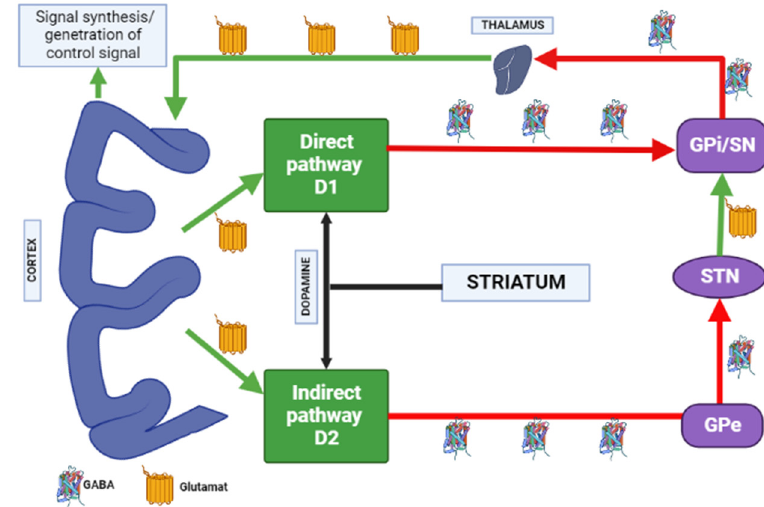
Figure 4. Distribution of A1 and A2A adenosine receptors in the human brain. Note: GPe—globus pallidus external; GPi—globus pallidus internal; STN—subthalamic nucleus; SN—substantia nigra; GABA—gamma aminobutyric acid.